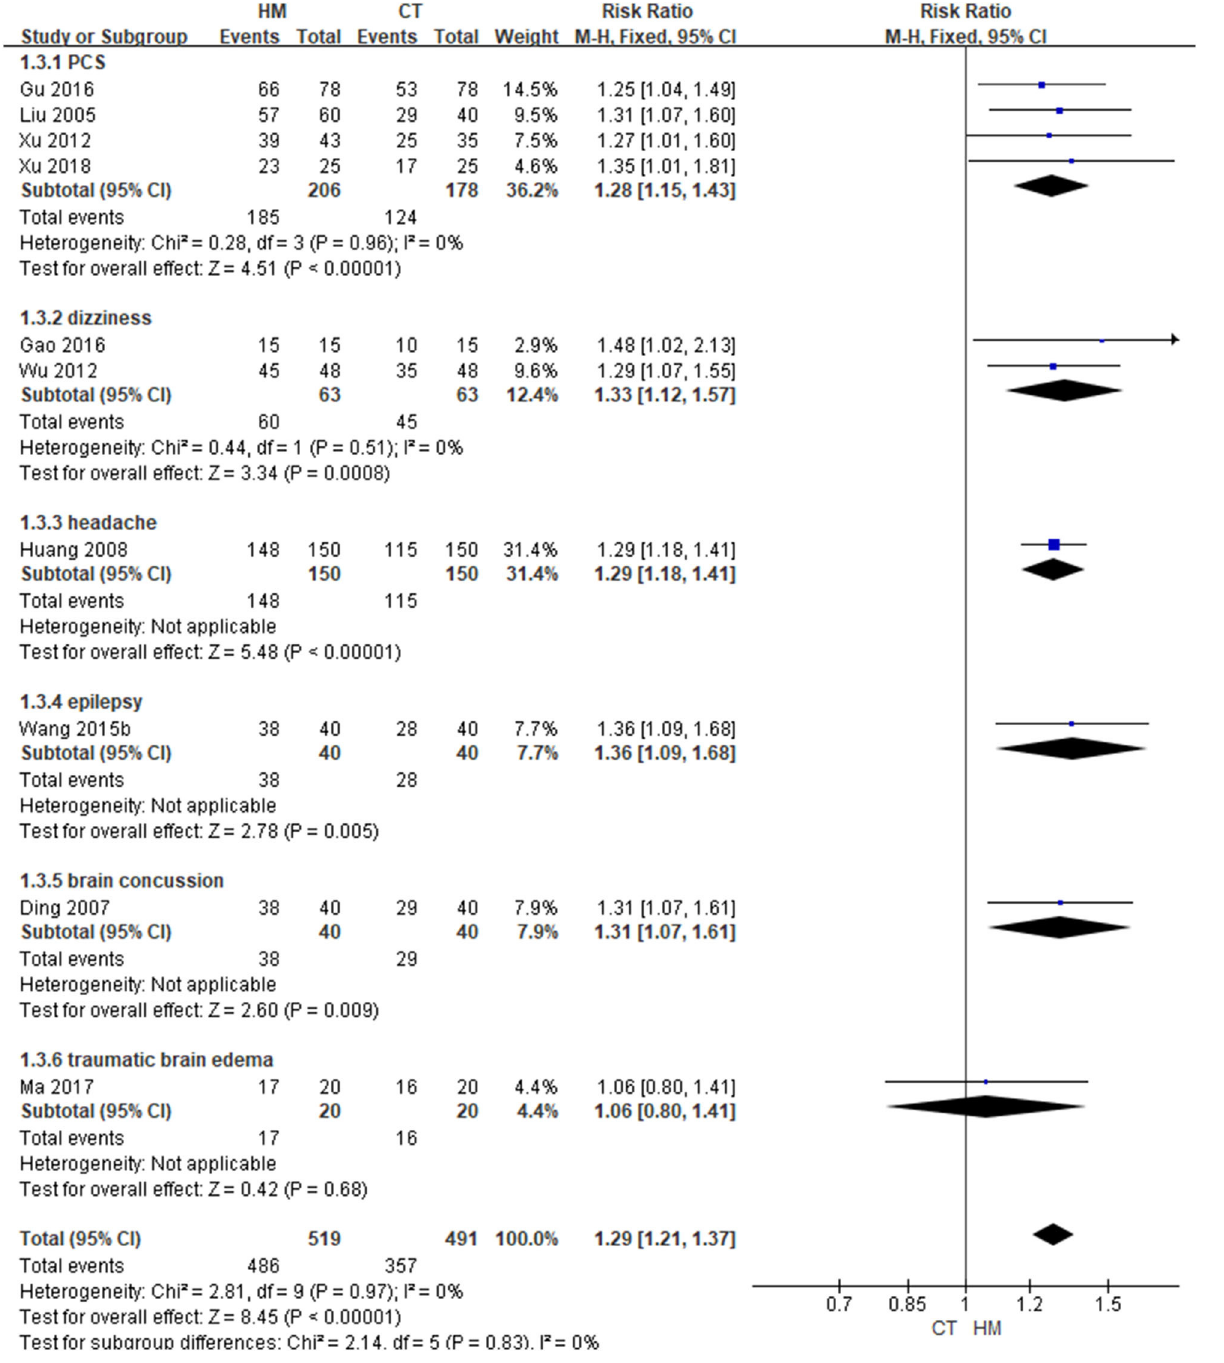
the groups after 1 month of post-intervention follow-up ( P < 0.05)